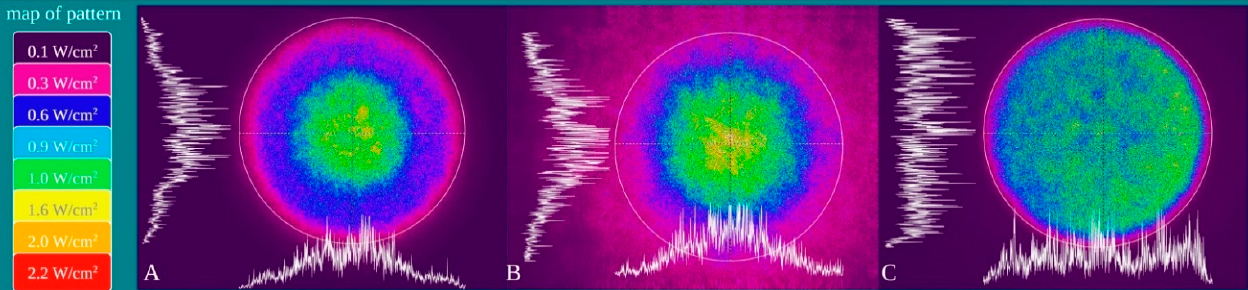
Figure 3. Characterization of the fibre ( A ), standard hand-piece ( B ) and the novel flat-top hand-piece prototype; ( C ) beam profile through a camera Spiricon SP928 equipped with the software BeamGage Professional. Setting the instrument for an irradiation with 1 W the main colours displayed are: purple = 0.1 W/cm 2 ; fuchsia = 0.3 W/cm 2 ; blue = 0.6 W/cm 2 ; light blue = 0.9 W/cm 2 ; green = 1 W/cm 2 ; yellow = 1.6 W/cm 2 ; orange = 2.0 W/cm 2 ; red = 2.2 W/cm 2 .